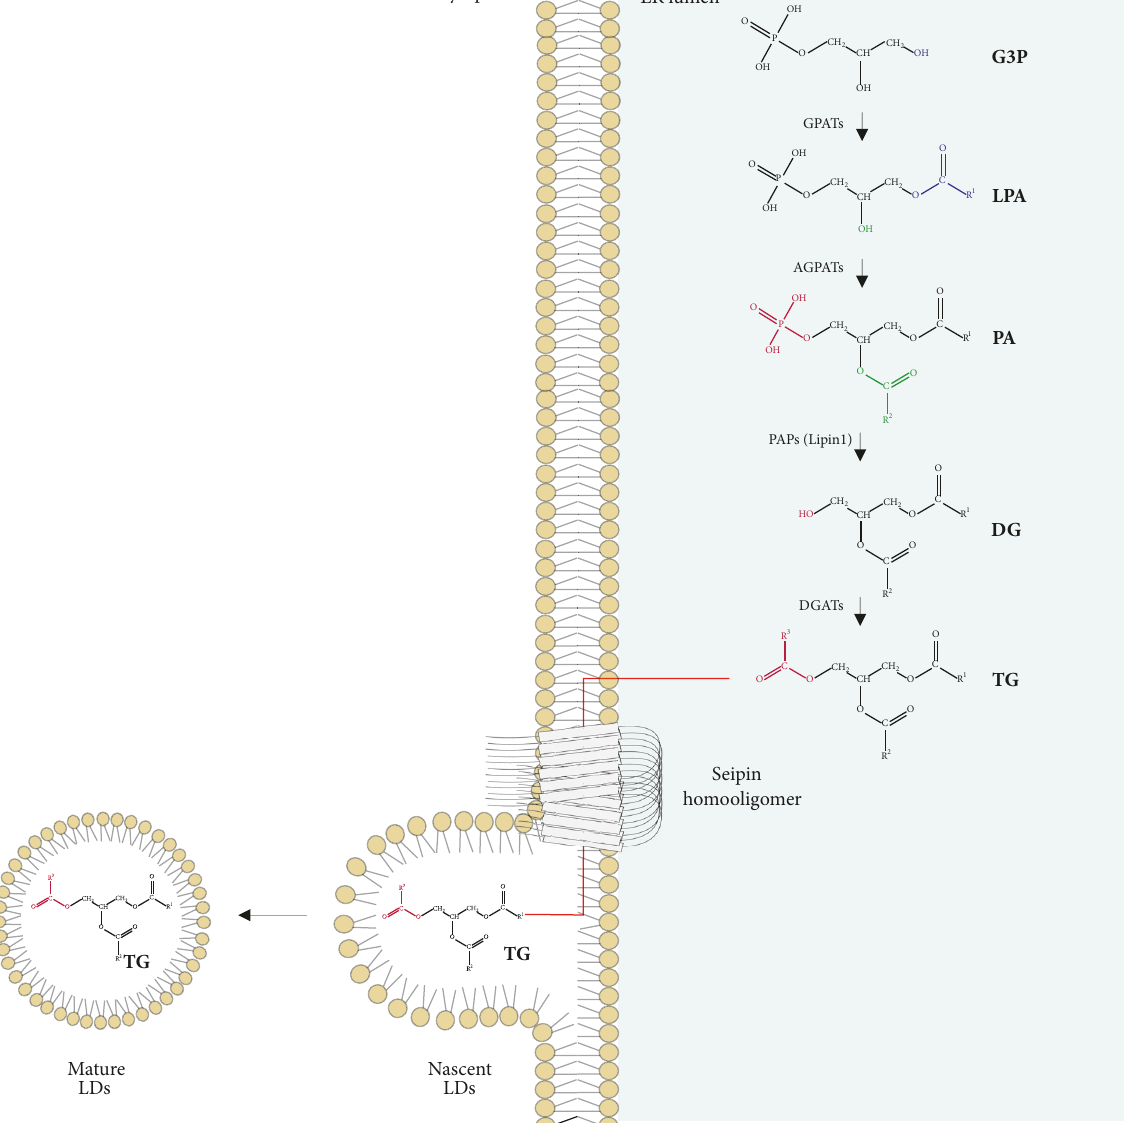
Figure 3: Triacylglycerol synthesis and usual seipin localization. During triacylglycerol synthesis, glycerol-3-phosphate acyltransferases (GPATs) catalyze the acylation at sn-1 position of glycerol-3-phosphate (G3P) and origin lysophosphatidic acid (LPA). Then, 1-acyl-sn- glycerol-3-phosphate acyltransferases (AGPATs) catalyze the acylation at sn-2 of LPA and give rise to phosphatidic acid (PA). Later, phosphatidate phosphatases (PAPs), as lipin1, can remove the phosphate group from PA and produce diacylglycerol (DG). Finally, diacylglycerol o-acyltransferases (DGATs) catalyze the acylation at the sn-3 position and give rise to triacylglycerol (TG) [35, 36]. In the same context, seipin comes as an oligomeric endoplasmic reticulum (ER) transmembrane protein that acts in lipid droplet (LD) assembly. ER and LDs were found to be neighbors, and seipin is concentrated in the communication regions between them, enabling the transfer of lipids recently synthetized to nascent LDs [37–39]. Pieces of the illustrations are from the SMART website